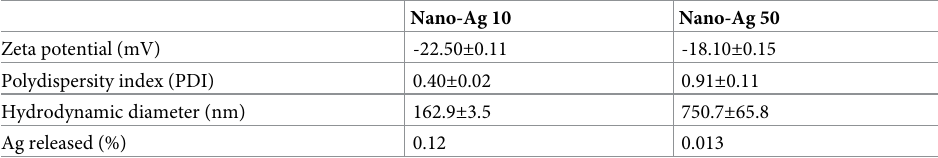
Table 1. Characterization of